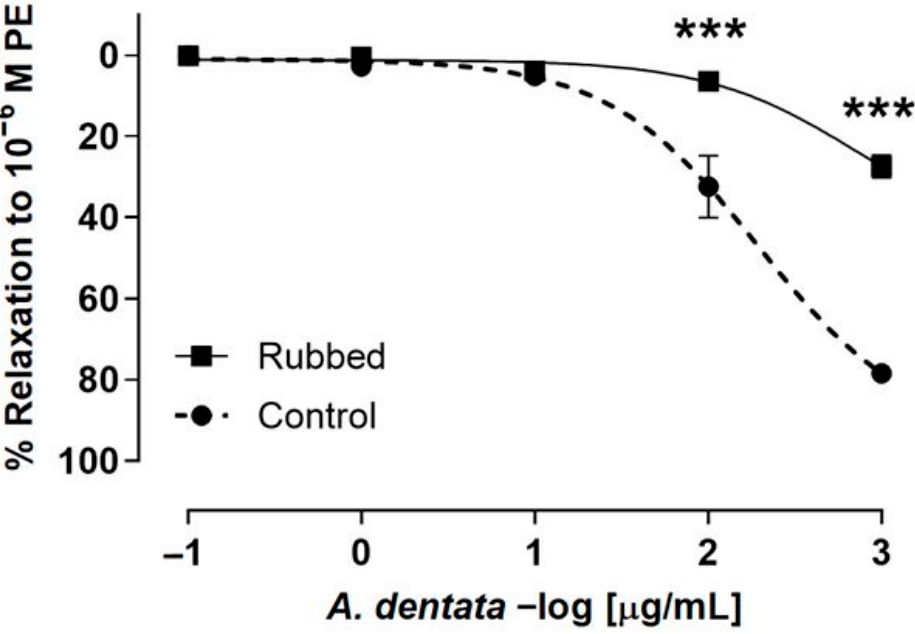
Figure 4. A. dentata extract caused relaxation in rat aorta depending on the vascular endothelium. Effect the extract on the intact aortic rings (control) versus endothelium denuded (rubbed). Data are reported as the average SE of the mean (SEM) of 5–7 independent experiments. *** p < 0.001. Table 5. Relaxation effect of A. dentata in pre-contracted aortic rings with PE in the absence of endo- thelium (rubbed), presence (control), and pre-incubated with 10 − 4 M L-NAME.